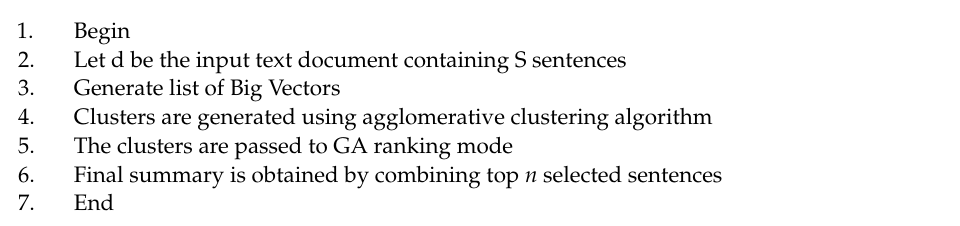
Algorithm 5: Proposed Model